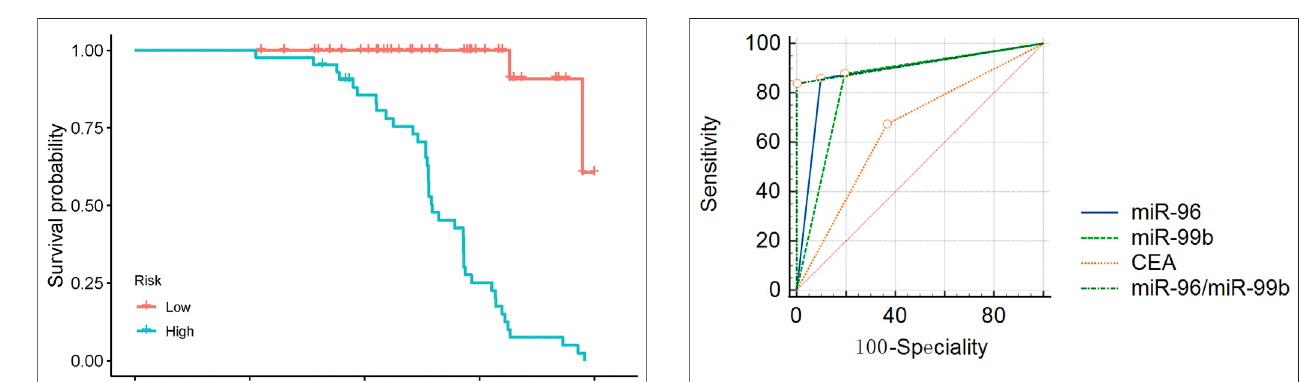
FIGURE 8 | ROC curve analyses in 49 mCRC and 41 pCRC patients. miR-96, miR-99b, CEA and miR-96/miR-99b have satisfactory diagnostic valueformCRC patients.Amongthem,miR-96/miR-99b isthemostpowerful combination indicator in our study, with AUC (cid:2)